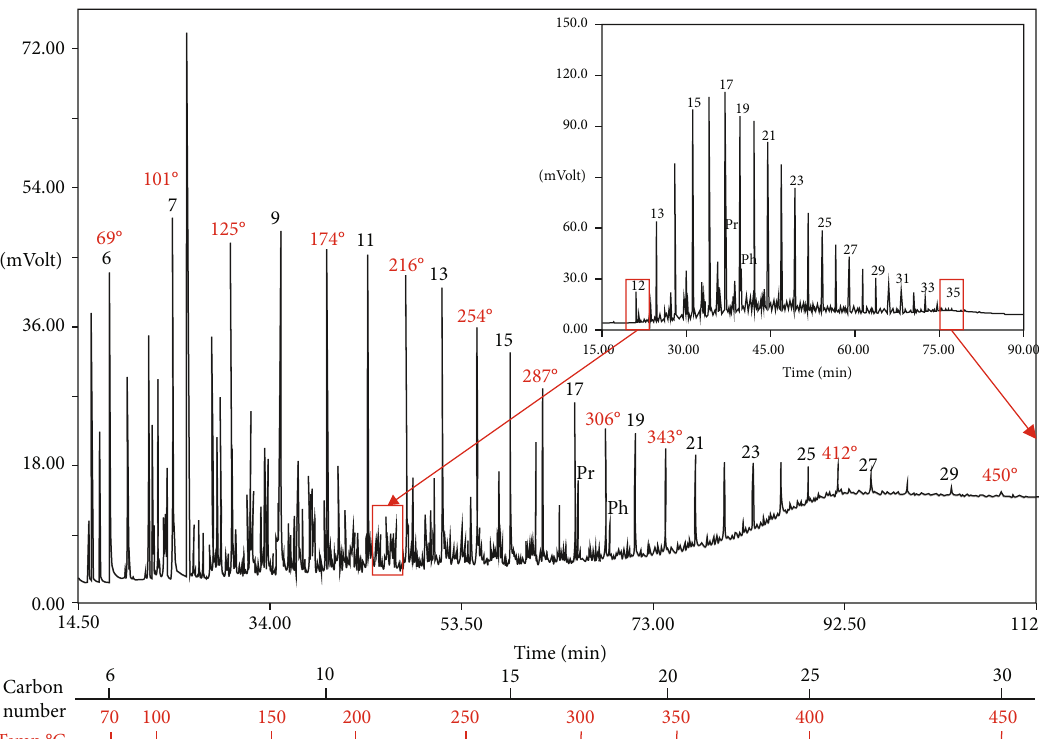
Figure 4: Exemplary chromatogram of Baltic Basin crude oil sample; blue shadow indicates hydrocarbons lost during saturated fraction separation; right upper corner — chromatogram of saturated fraction. It was assumed that the amount of hydrocarbons lost in the separation procedure (shadowed) corresponds (although not literally) to the scale of lighter compounds evaporation from core samples during its preparation for Rock Eval measurement.